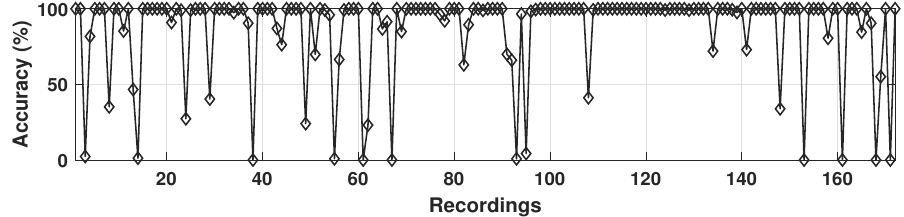
Figure 7. Accuracy values obtained using the proposed MMDCNN classifier for MI detection with leave one out CV strategy. Table 9. Classification results of MMDCNN obtained using selected modes and all modes for the detection of MI. Mode Selection